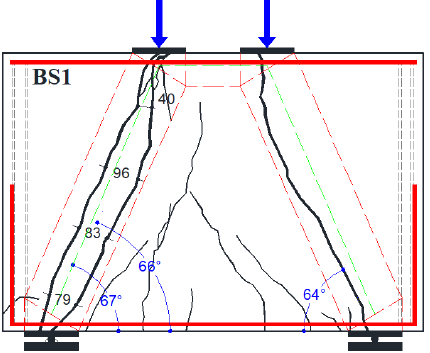
Figure 27: Crack pattern and mode of failure for vertical web rein- forcement only with ratio 0.40%